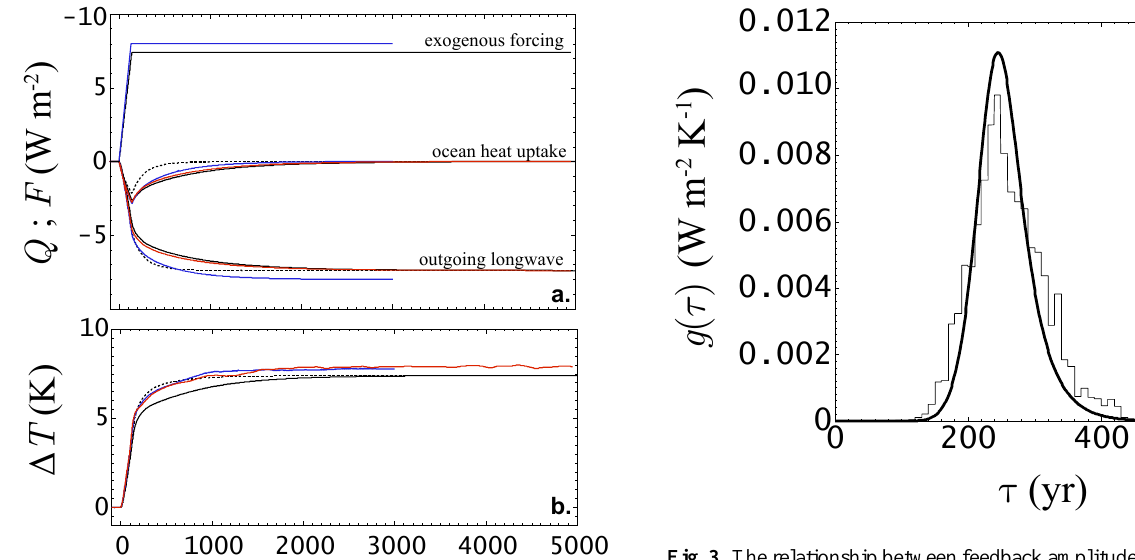
Fig. 3. The relationship between feedback amplitude, g , and its cor- responding time constant, τ , for a synthetic test case. The thick line has been used to generate a unit step response to which the structure in Fig. 1 has been optimised using the simulated annealing method- ology outlined in the text. The thin line is the resultant estimate of the same